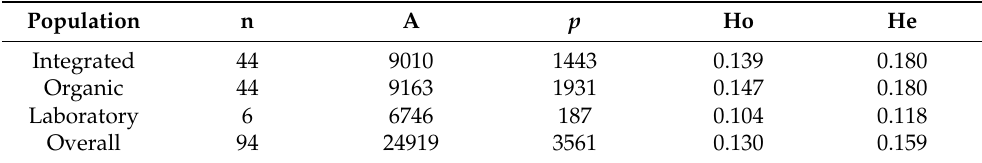
Table 2. Detailed allelic diversity estimates of Cydia